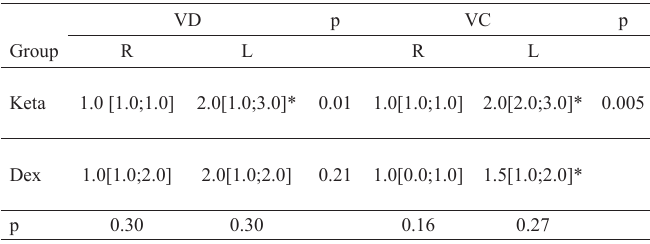
TABLE 1 - Scores of vascular dilation (VD) and vascular congestion (VC) in the right (R) and left (L) kidney according to group, keta or dex.